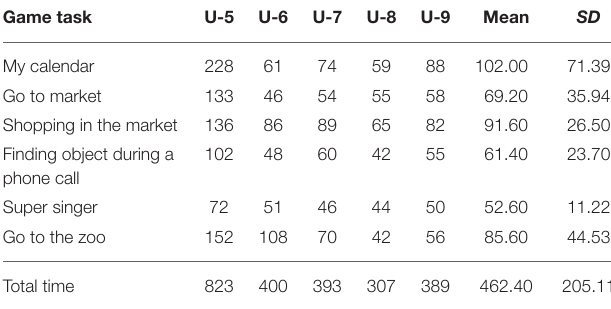
TABLE 7 | Completion time of game task